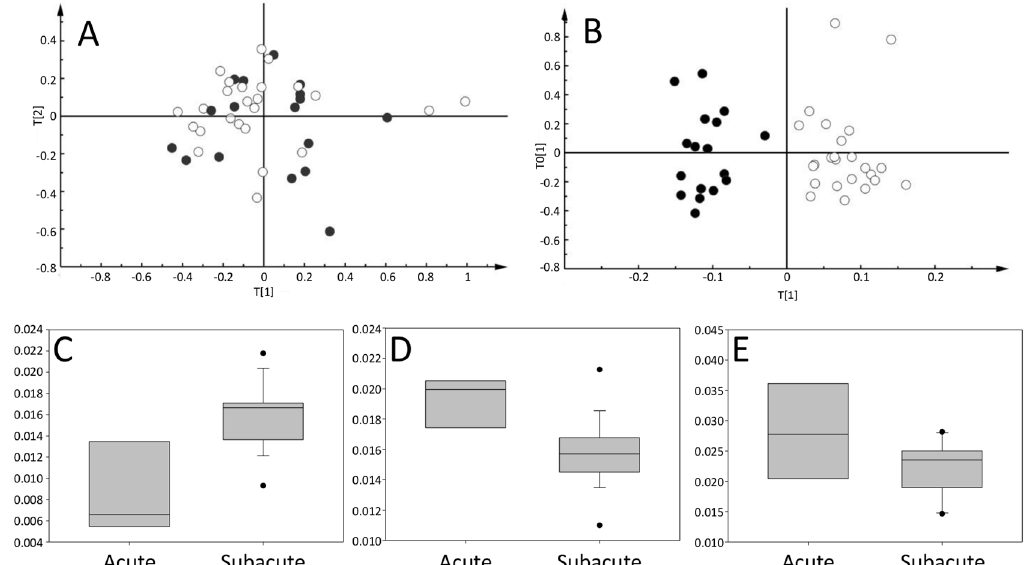
Figure 3. Classification between acute and subacute phase of TKS. ( A ) score plot of the principal component analysis. ( B ) OPLS-DA score plot of the same samples as shown in A; black dots correspond to acute ( n = 19) and white circles to subacute samples ( n = 28). ( C – E ) correspond to the box plots for Alanine, Creatine, and Glucose, respectively, between acute and subacute TKS